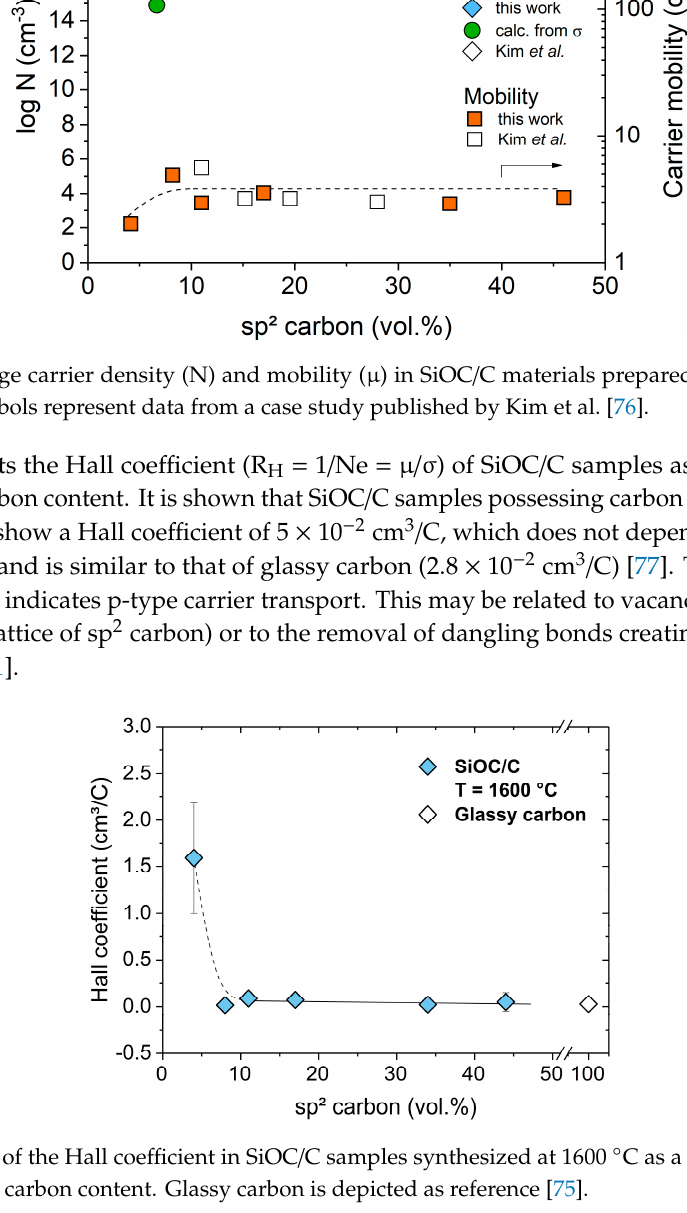
sp 2 -hybridized carbon content. Glassy carbon is depicted as reference